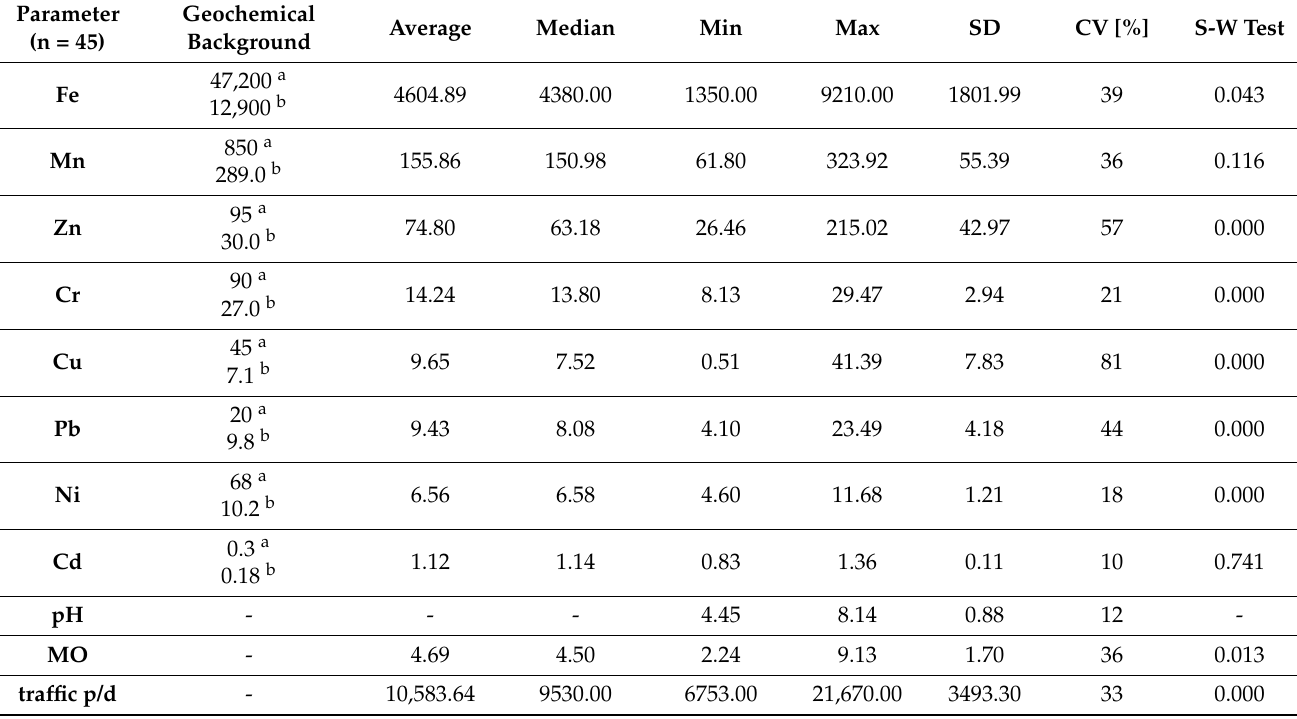
80% of samples were with neutral or alkaline pH values found within urban, rural and agricultural areas. Table 3. Descriptive statistics of metal concentrations [mg · kg − 1 ], pH and MO [%] in roadside soils (SD—standard deviation, CV—coefficient of variation, - (dash)—not applicable).